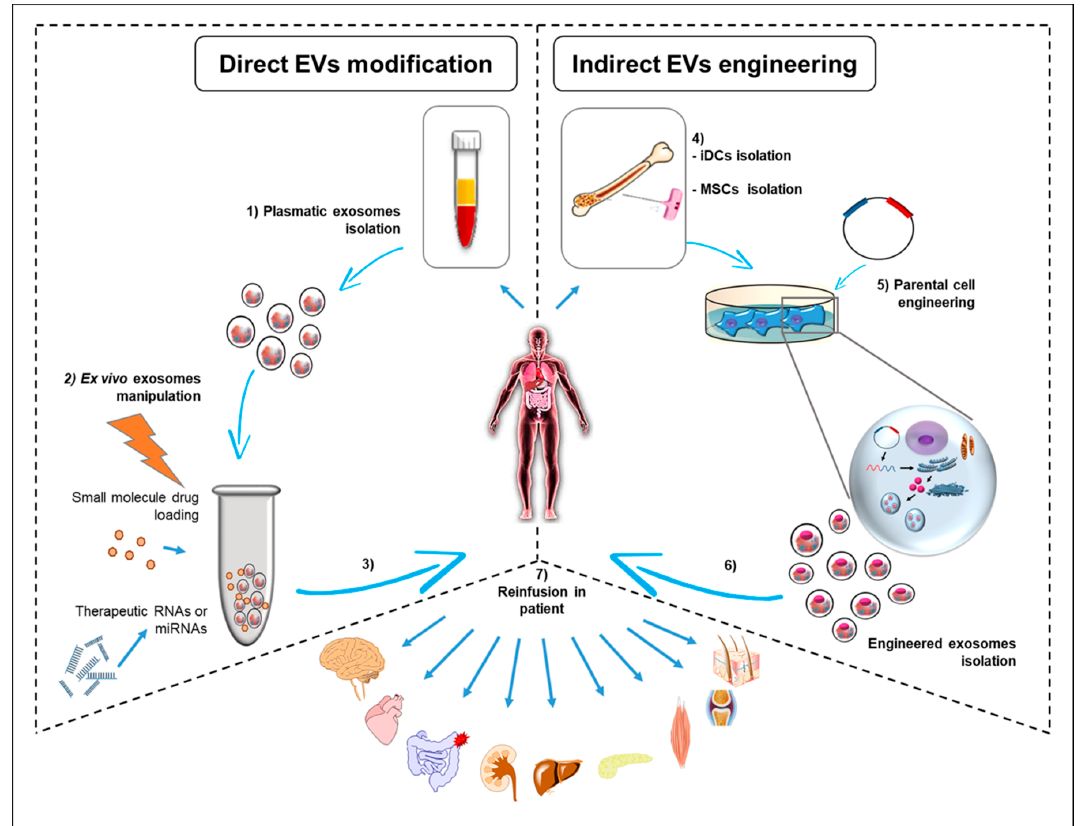
Figure 1. Exosomes as nanomedicine tools. Exosomes can be isolated from the patient, starting from all body fluids. The less invasive access is represented by a simple blood sample (liquid biopsy), by which it is possible to isolate circulating exosome (1), potentially released by all body cells. These “self” exosomes obtained can be loaded with drugs (2), such as peptides or small molecules, otherwise with therapeutic RNAs or miRNAs and then reinfused in the same patient for the therapeutic purpose (3). Another approach consists in the possibility to isolate and manipulate, for instance, immature dendritic cells (iDCs) or mesenchymal stem cells (MSCs) (4), with the aim of producing exosomes bearing therapeutic molecules (5). The engineered exosomes may be administered to the patient (6) as a treatment of diseases affecting various organs, or to exploit the recognized regenerative capacities (7).